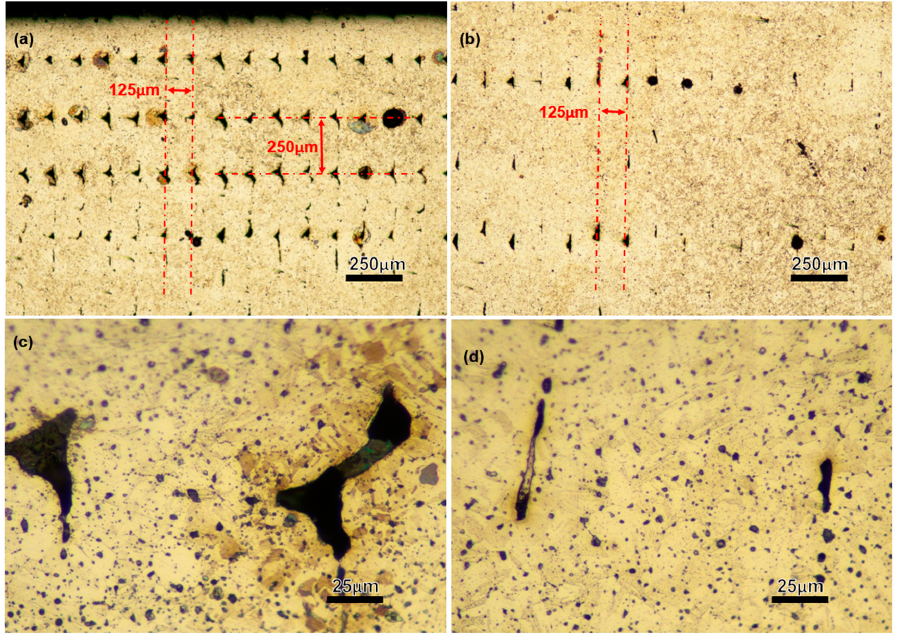
Figure 14. For a polished and etched surface of an as-sintered V block’s cross-section (Section A-A Figure 3), layer interface/track boundary voids at the ( a , c ) wall region and ( b , d ) the infill region and ( d ) pores/voids at the infill/main part region (the building direction is along the red arrow shown in ( b )). Voids/porosities affect the part’s mechanical performance [3,20,32,33]. The shape (ir- regular-shaped, spherical, sharp corners, etc.), size, and distribution of voids can be es-